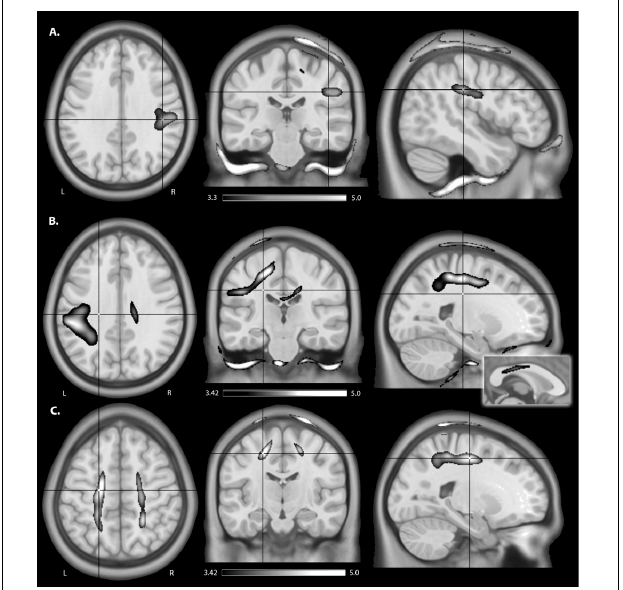
FIGURE 5 | An illustration of areas of higher estimated electric field strength in children compared to adults using (A) isotropic WM maps for anodal tDCS, (B) anisotropic WM tensors for cathodal, and anisotropic WM tensors for (C) bihemispheric tDCS montages. Shown are statistical T -score heat maps overlaid on three orientations (axial, coronal, sagittal) of an MNI template brain [significance threshold: T (33) > 3.3, p < 0.001]. These maps display statistical T -score heat maps [significance threshold T (27) > 3.42, p < 0.001] overlaid on an MNI template brain. The inset for (B) on the midline sagittal slice illustrates higher estimated EF in the transcallosal motor fibers of the corpus callosum for children compared to